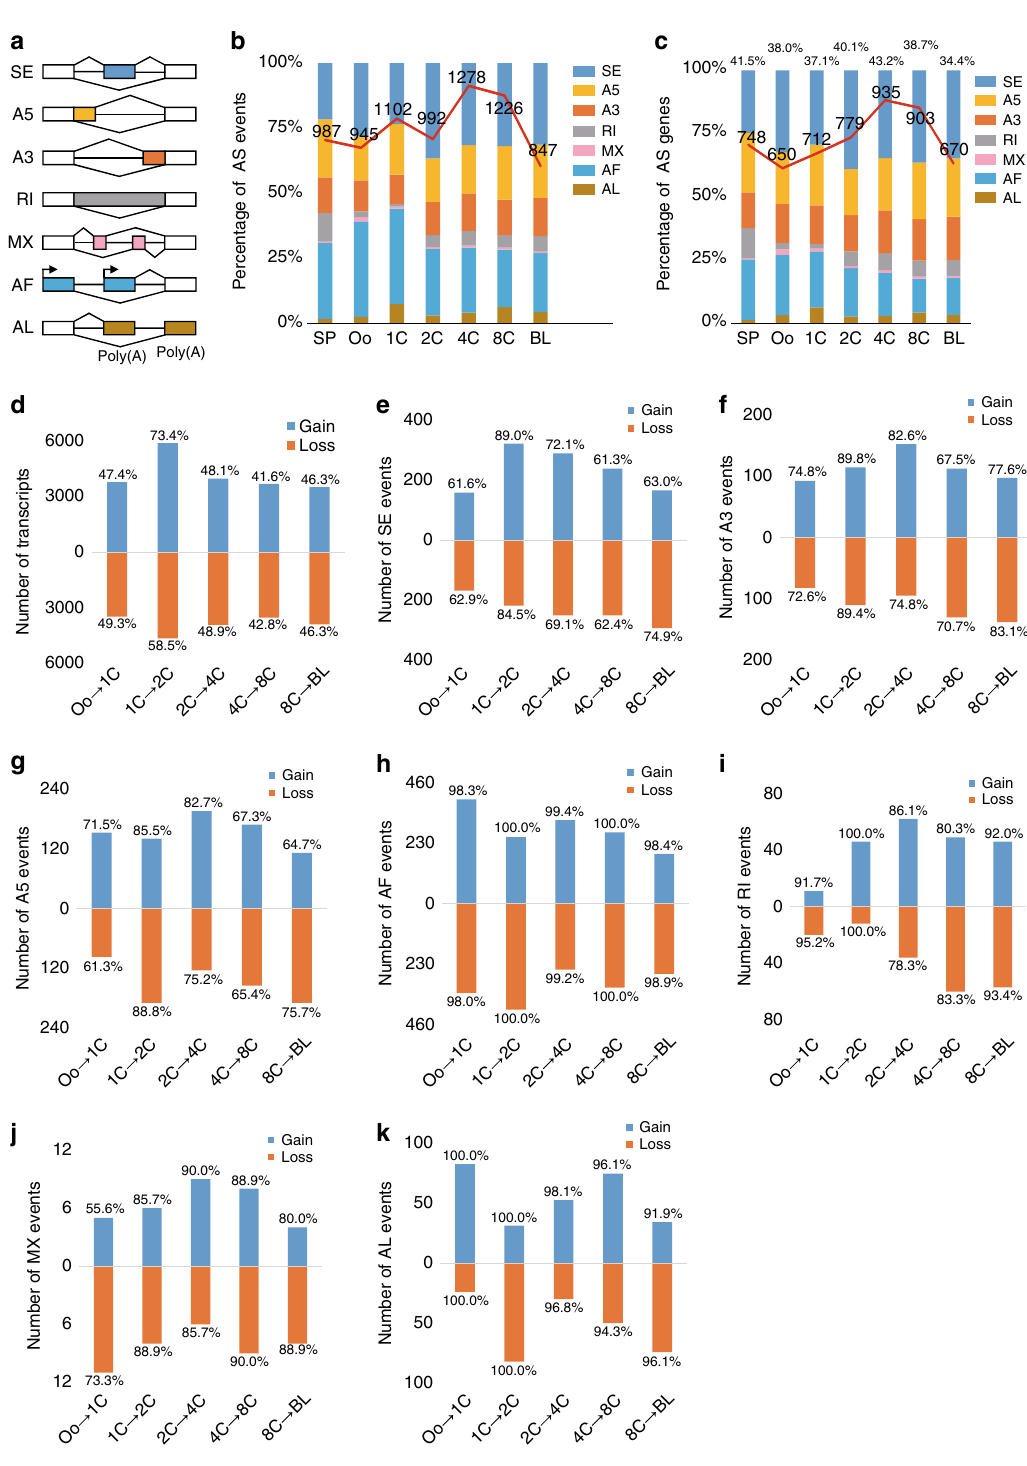
Fig. 3 Identi fi cation of alternative splicing (AS) events and differential splicing events in seven stages of preimplantation mouse embryos. a Schematic diagram of the seven types of AS events. b Distributions of AS events in the seven stages. The percentages (bar) and total numbers (red line and indicated numbers) of AS events in the seven classes are presented in each stage. c Distribution of AS genes in the seven stages. The percentages (bar) and total numbers (red line and indicated numbers) of AS genes in the seven classes are presented in each stage. The percentages at the top of the bars represent the proportions of total AS genes among total genes with multiple isoforms in each stage. d Numbers of long-read transcripts gained or lost in consecutive stages. The percentages at the top of the bars represent the proportions of gained transcripts among the total transcripts of the later stage, and the percentages at the bottom of the bars represent the proportions of lost transcripts among the total transcripts of the previous stage. e – k Numbers of AS events of seven types, which were gained or lost in consecutive stages. The percentages in the top of bars represent the proportion of gained events relative to the total AS events in the latter stage, and the percentages in the bottom of bars represent the proportion of lost events relative to the total AS events in the previous stage. e for SE, f for A3, g for A5, h for AF, i for RI, j for MX and k for